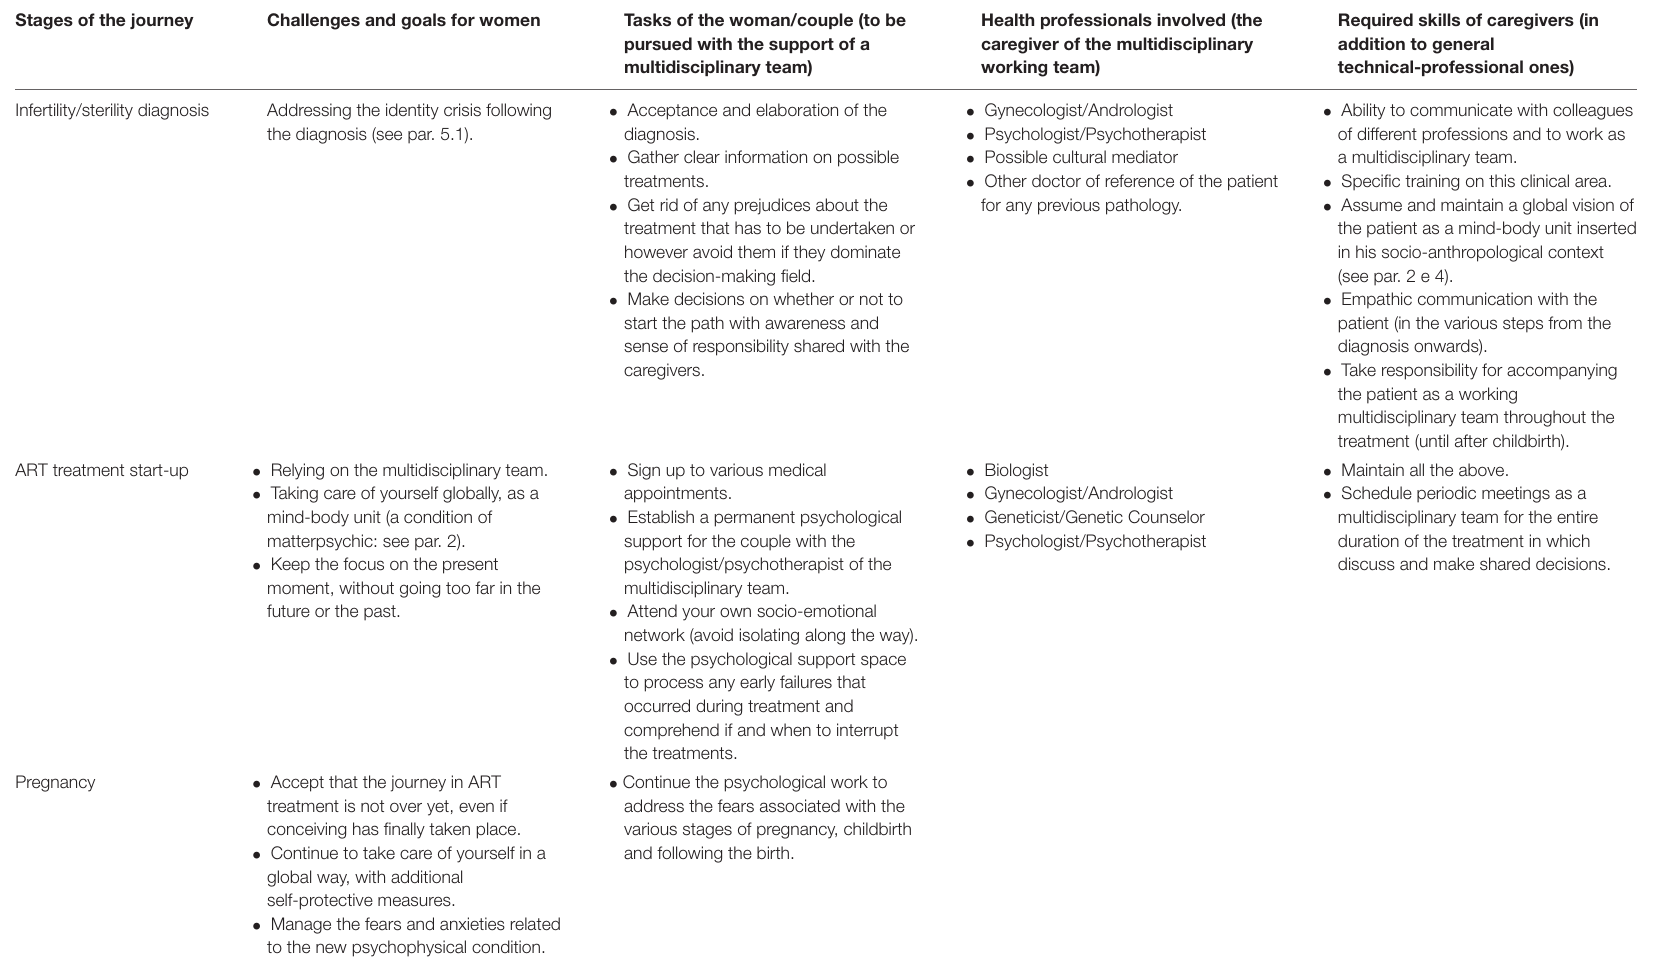
TABLE 1 | The stages of woman/couple’s journey in ART treatments. Stages of the journey Challenges and goals for women Tasks of the woman/couple (to be